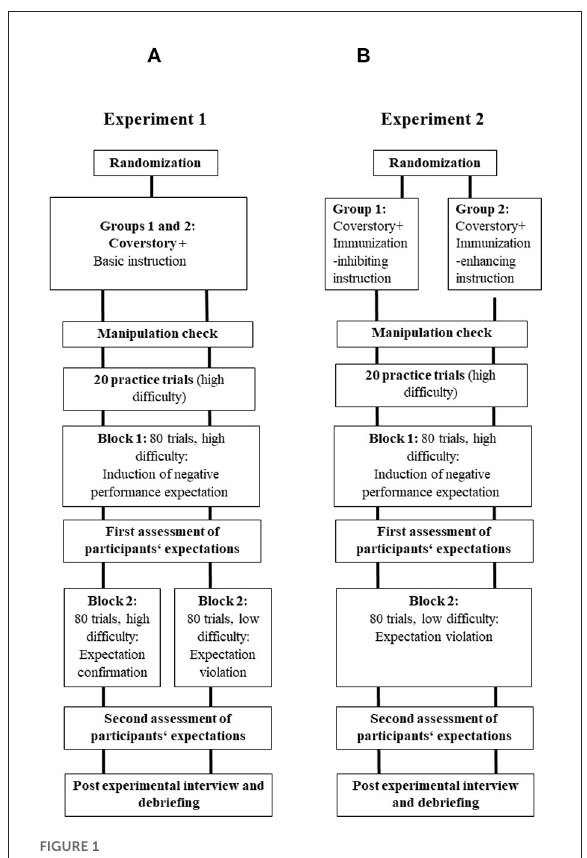
FIGURE1 The basic procedure of the two experiments. Experiment 1 (A) : A cover story, a training block and a test block induced negative expectations regarding one’s ability to succeed in an unknown test. After the first test block, we assed participants’ expectations. The procedure continues with a second test block with either a high (group 1) or a low (group 2) difficulty to confirm (group 1) or disconfirm (group 2) the initial expectation. Afterward, we assessed participants’ expectations for the